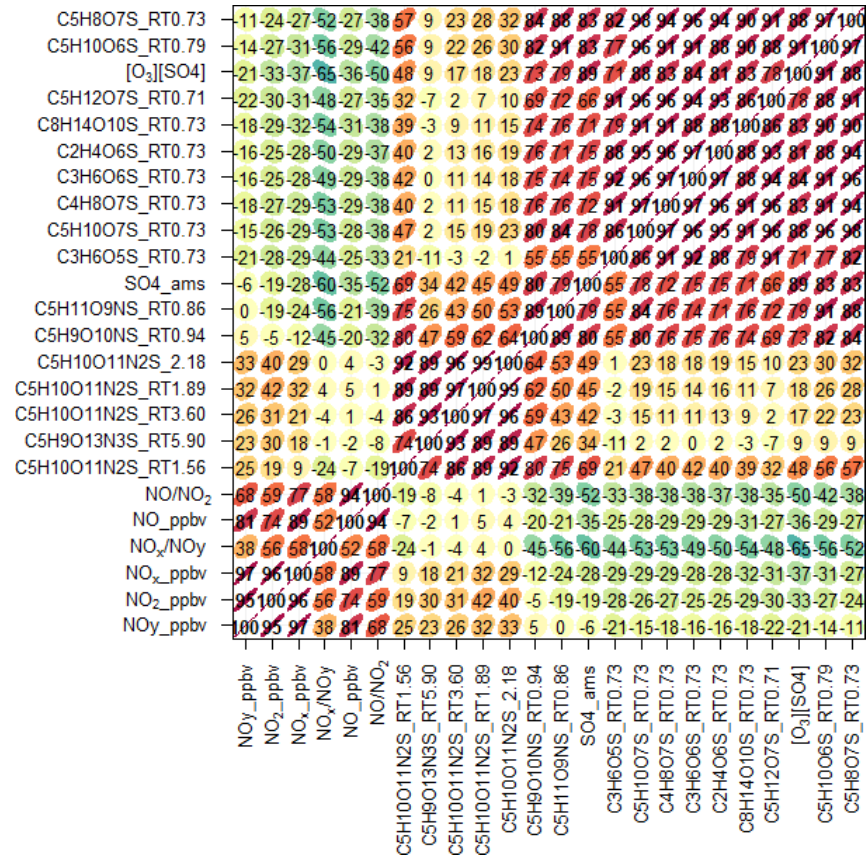
Figure 5. Correlation plot (R, openair, corPlot) highlighting the correlations between known iSOA tracers and anthropogenic pollutants. The numbers represent the R correlations between the two species; the redder, more elongated circles highlight a higher correlation.